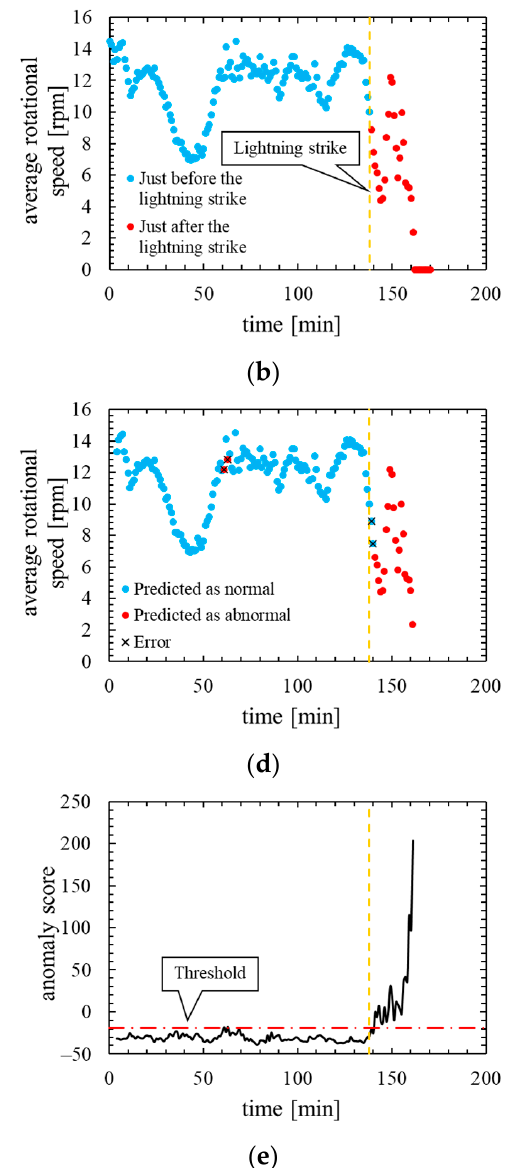
Figure 14. True label and assessment result of the model in which the number of mixture components K was 256 (threshold is 100th percentile’s value): ( a ) wind speed rotational speed characteristic with true label; ( b ) time characteristics of rotational speed with true label; ( c ) wind speed rotational speed characteristic with predicted label; ( d ) time characteristics of rotational speed with predicted label; ( e ) time characteristics of anomaly score.